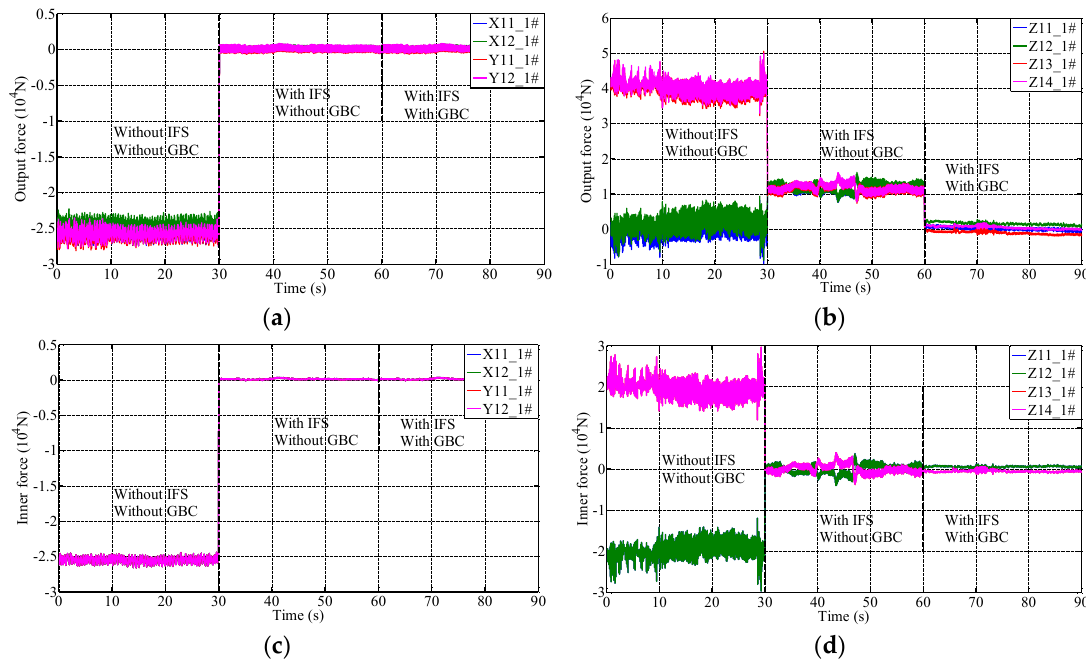
Figure 15. The output forces and inner forces with different controllers at 0 position. ( a ) The horizontal output forces; ( b ) The vertical output forces; ( c ) The horizontal inner forces; ( d ) The vertical inner forces.